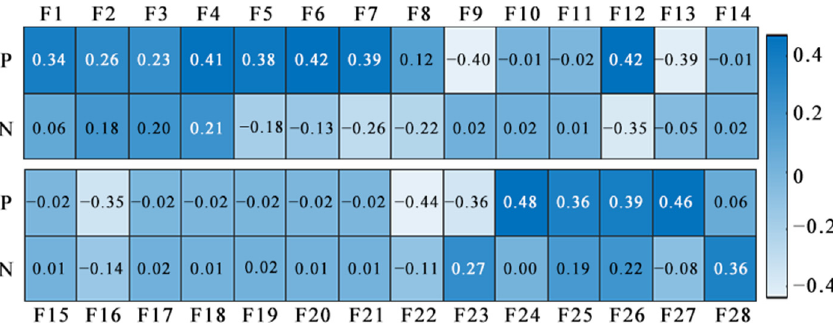
Figure 2. The r between TP/TN and model input indices. F1–F6 are single bands, including blue, green, red, near-infrared (NIR), shortwave infrared 1 (SWIR1), and shortwave infrared 2 (SWIR2). There are positive correlations between TP and F 1-band , and the correlation with F6 (SWIR2) is the strongest (r = 0.42). The correlation between TP and F4 (NIR) is similar to that of F6 (r = 0.41), the correlations with F1 (blue) and F5 (SWIR1) are between 0.3 and 0.4, and the correlations with the other two are between 0.2 and